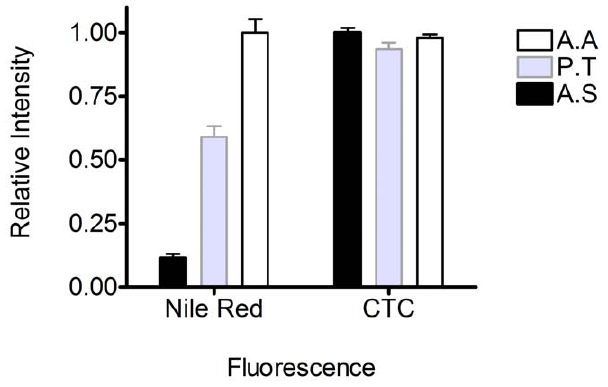
Figure 4. Fluorescence measurements of Nile red and CTC for EPS. EPS extracted from various phytoplankton, Amphora sp. (black), Phaeodactylum tricornutum (grey) , and Ankistrodesmus angustus (white).